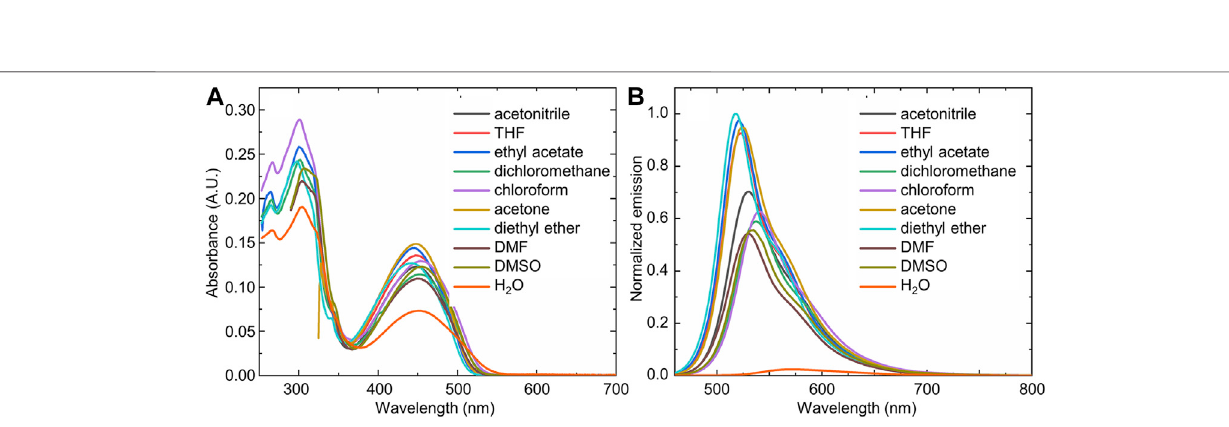
Frontiers in Chemistry |